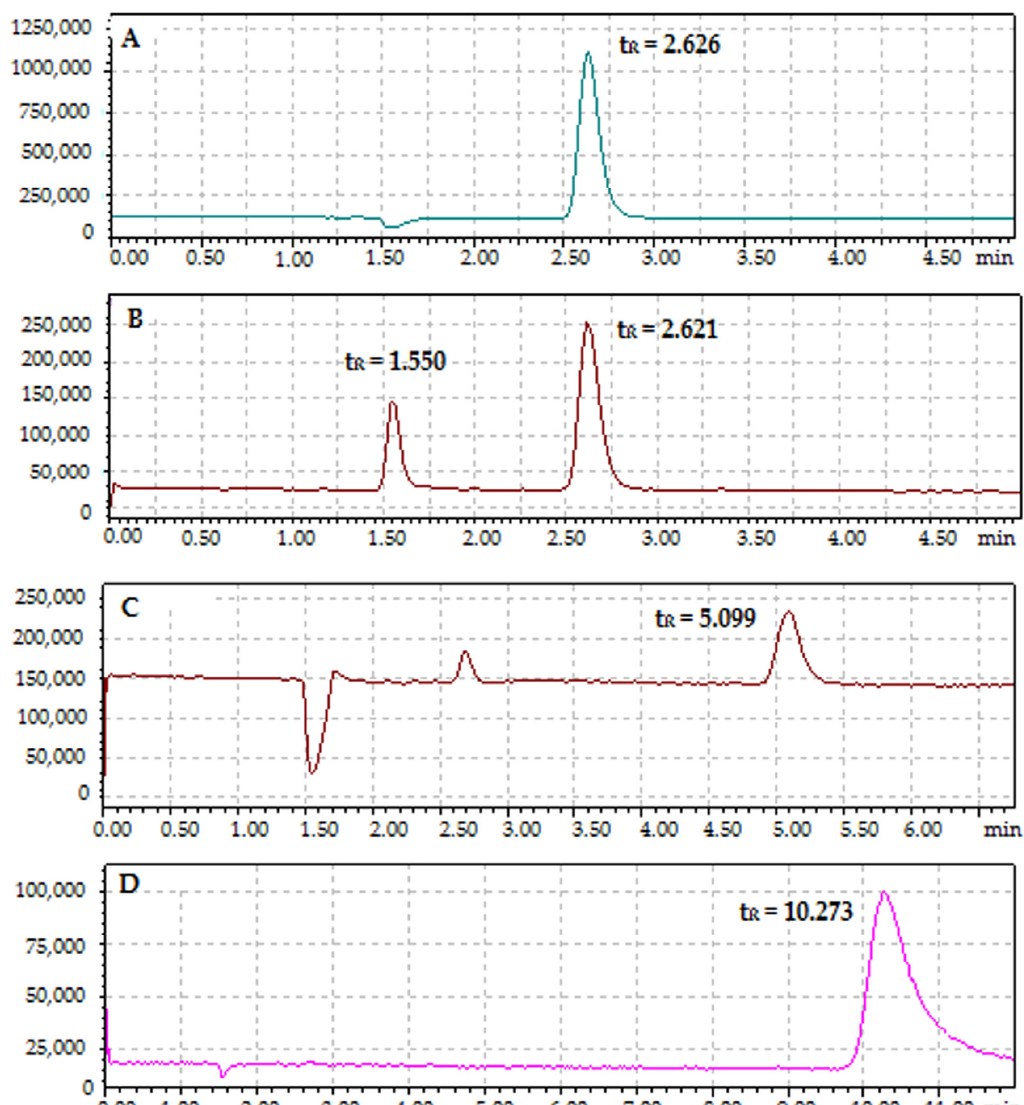
Figure 4. Chromatograms of: ( A ) adonitol; ( B ) D-sorbitol; ( C ) shikimic acid; and ( D ) D-( – )-quinic acid (under the following conditions: stationary phase, column filled with BSA; mobile phase, water + 0.1% v/v